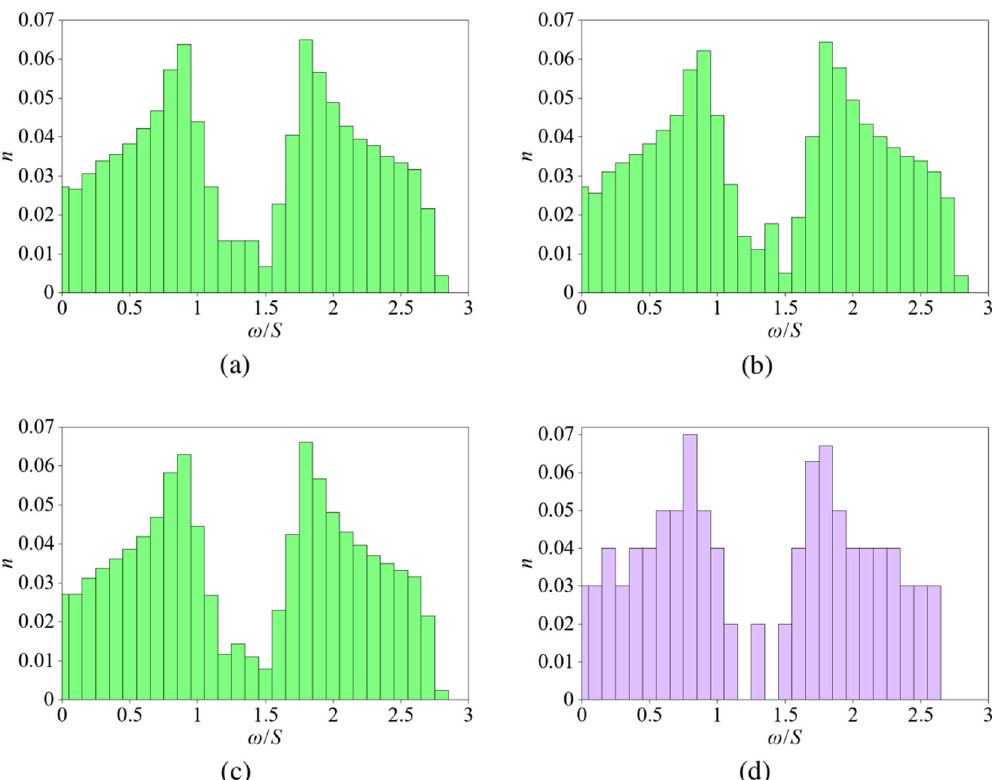
Fig. 4 Benchmarking the mean- fi eld theory. Magnon densities of states of a a random vortex con fi guration and b another, at φ ¼ tan (cid:2) 1 ð 1 = 2 Þ and h / S = 1.3, on a lattice with 1800 sites, obtained by real space linear spin wave theory. c Magnon density of states obtained by averaging the data from 80 different random vortex con fi gurations like a and b , at the same parameters. d Magnon density of states in the mean- fi eld approximation, at the same parameters, obtained by momentum space linear spin wave theory. Here, we use 100 × 100 k points in the fi rst Brillouin zone de fi ned by the optimal gauge (see Fig. 3a) with p = 1 and q = 50. In a – d , the vertical axis n represents the number of states normalized by the number of sites.